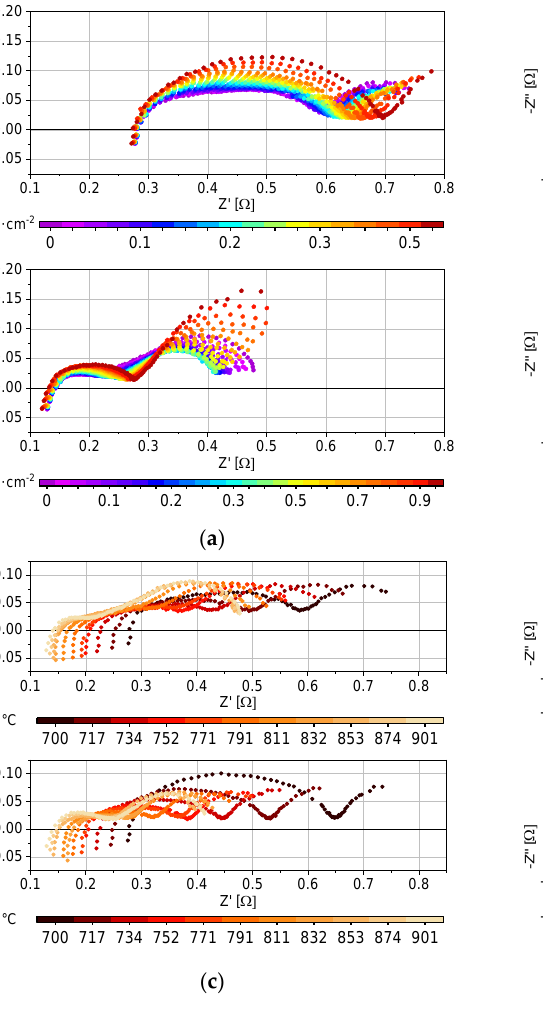
Figure 3. EIS spectra at various operating parameters: ( a ) variation of current density for a ratio of CO 2 :CO of 80:20 at 6 l·h −1 at 700 °C (top) and 900 °C (bottom); ( b ) variation of CO 2 :CO ratio at 800 °C and 6 l·h −1 at OCV (top) and 0.35 A·cm −2 (bottom); ( c ) variation of temperature for a ratio of CO 2 :CO of 80:20 at 6 l·h −1 at OCV (top) and 0.35 A·cm −2 (bottom); ( d ) variation of flow rate for a ratio of CO 2 :CO of 80:20 at 800 °C at OCV (top) and 0.35 A·cm −2 (bottom).